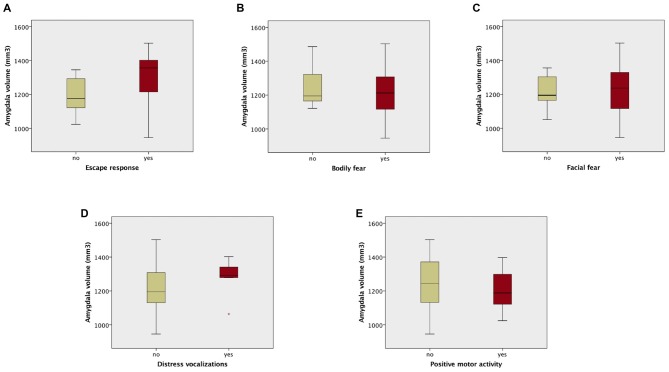
Box plots of amygdala volumes dichotomized between infants who showed no fear reaction (composite score of corresponding variable = 0), and infants who showed any fear reaction (composite score of corresponding variable > 0) to the fearsome mechanical dog episode. Reaction/no reaction infants groups were created based on the following composite scores: (A) escape response; (B) bodily fear; (C) facial fear; (D) distress vocalizations; (E) positive motor activity.